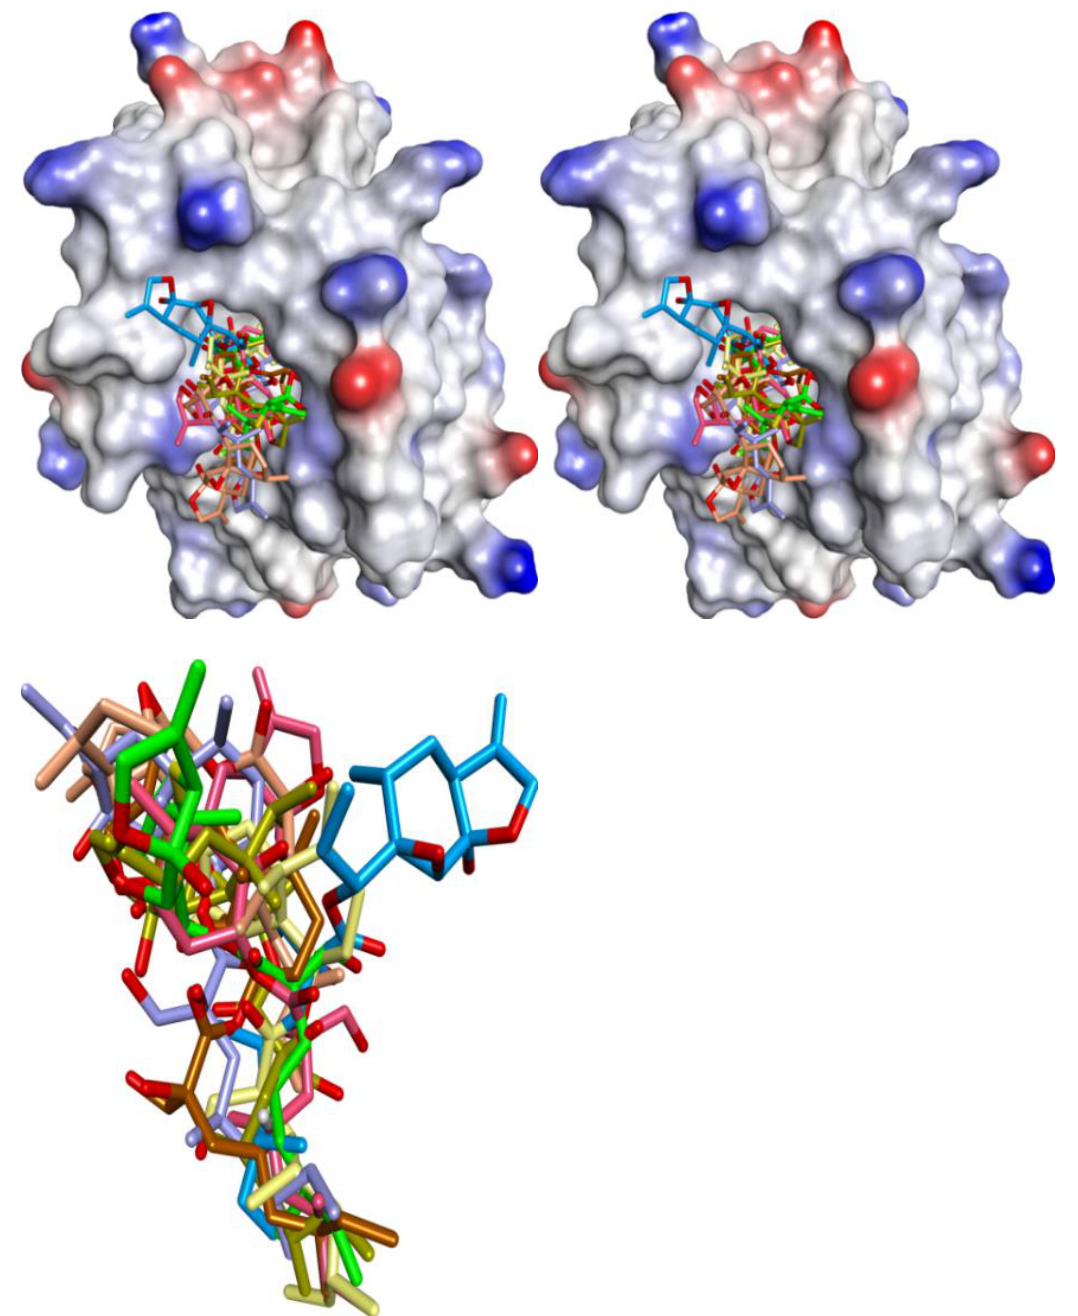
Figure 20. Eight stereoisomeric analogs of cryptosphaerolide can be possible based on specific stereochemistry at three chiral centers, therefore all eight isomers were docked. The cyclic substructures of all 8 isomers were not involved in binding (as seen in the binding mode in the figure for any of the eight stereoisomers (b: on the left-hand side) in the figure with